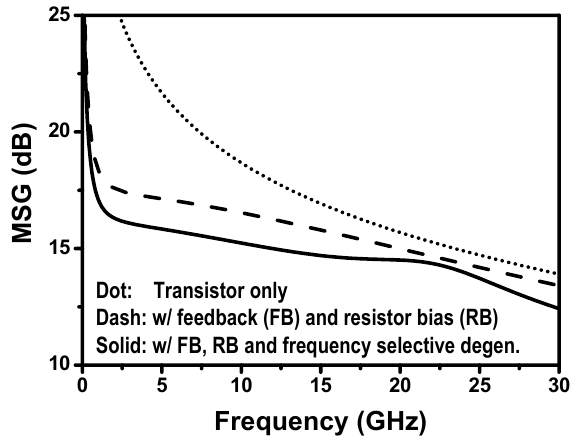
Figure 4. Simulated MSGs of the main stage with optimized resistance and capacitance of 1 Ω and 4.2 pF for the degeneration circuit, respectively. Table 1. Component values for the feedback, resistor bias, and frequency selective degeneration circuits. Main Stage Drive Stage